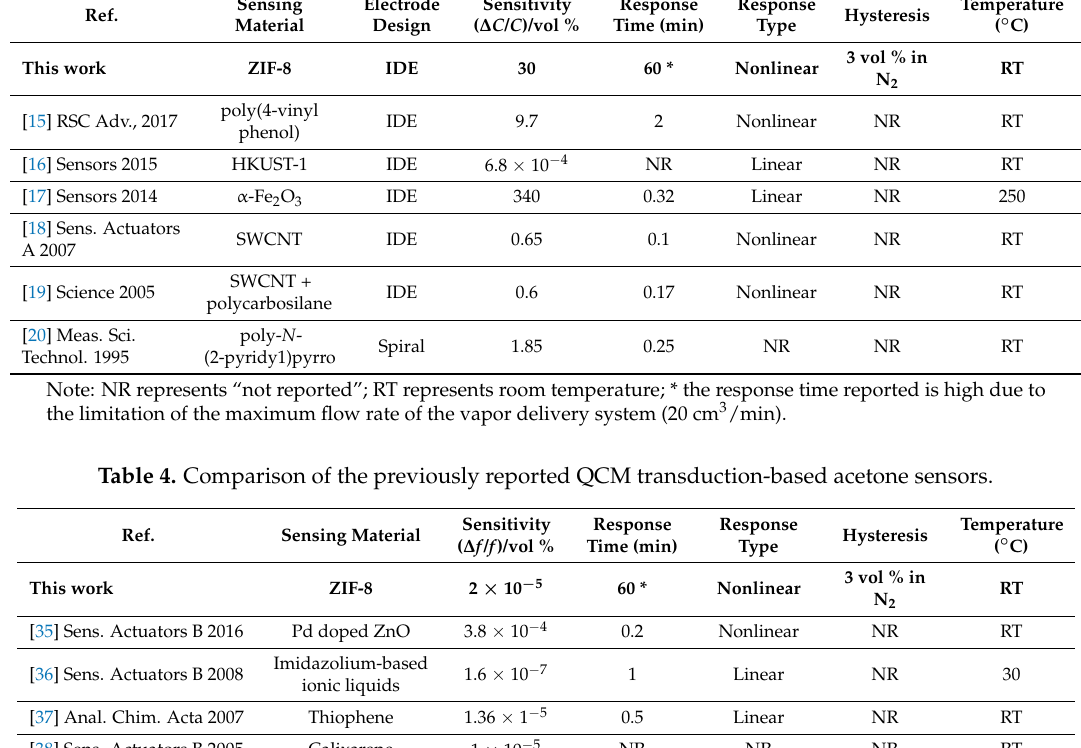
Table 3. Comparison of the previously reported capacitive transduction-based acetone sensors. Ref.